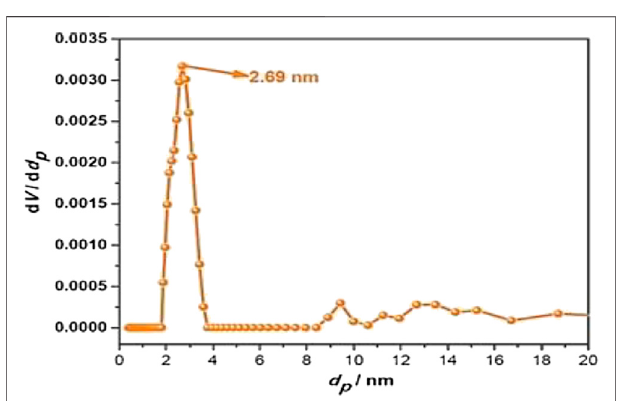
FIGURE 7 | Pore size distribution curve of Fe – Ag co-doped TiO 2 NPs.